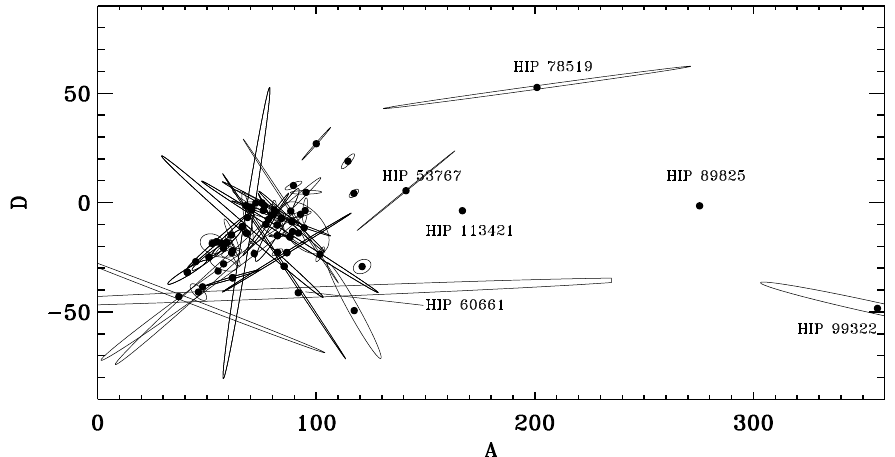
Fig. 1. The AD-diagram with the error ellipses for the Castor stream. The stars with large errors ellipses are marked by their HIP numbers. all stars, then discard the stars lying beyond 3 (cid:27) and repeat the procedure. After four iterations we find A = 79 : 33 ◦ , D = (cid:0) 15 : 06 ◦ based on the data for 65